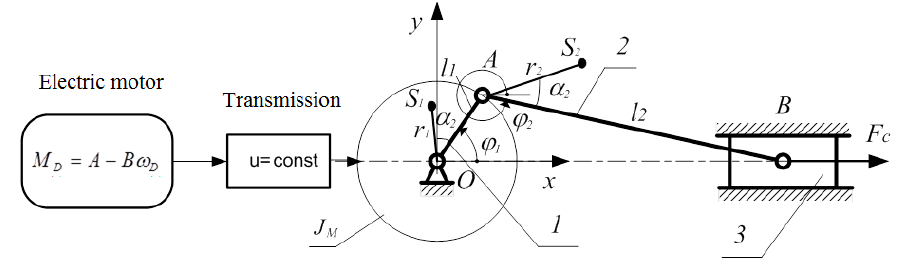
Figure 1. Diagram of the